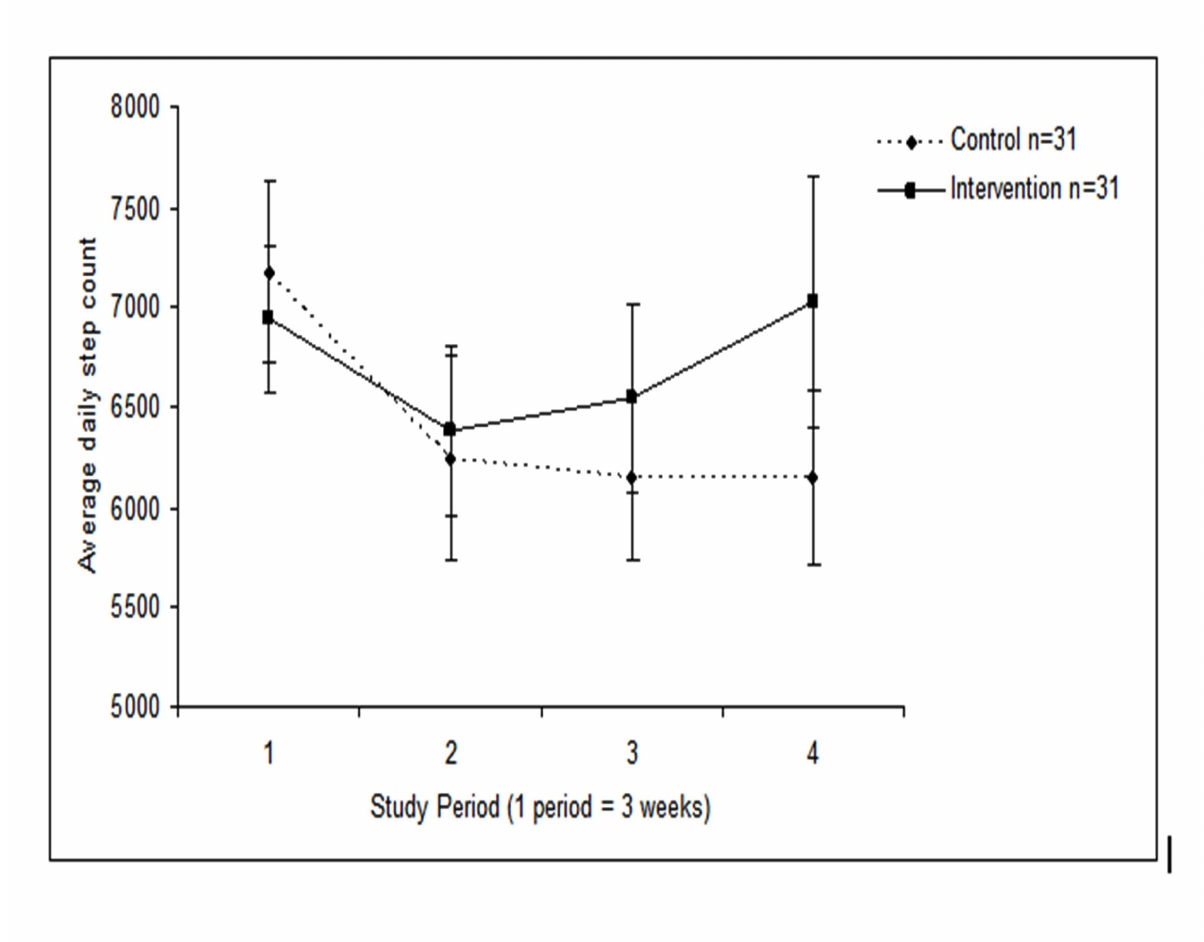
Figure 3. Average (SE) daily step count per period. Data shown for all participants who completed the study, including those with missing